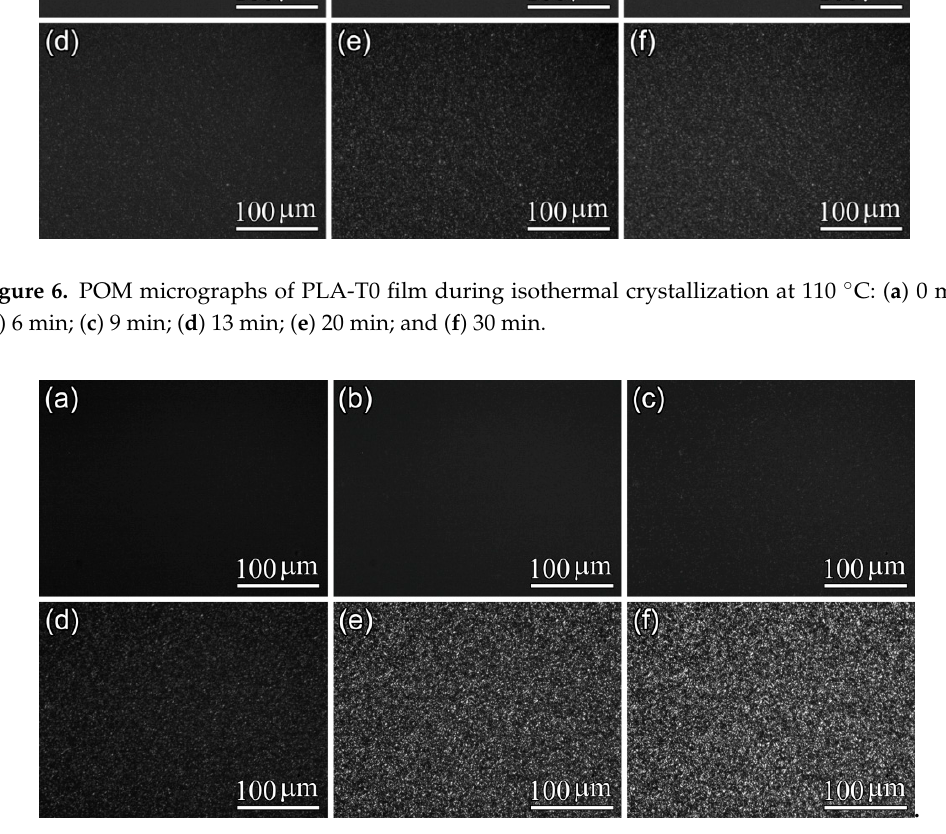
Figure 7. POM micrographs of PLA-T35 film during isothermal crystallization at 110 °C: ( a ) 0 min; ( b ) 6 min;( c ) 9 min; ( d ) 13 min; ( e ) 20 min; and ( f ) 30 min.